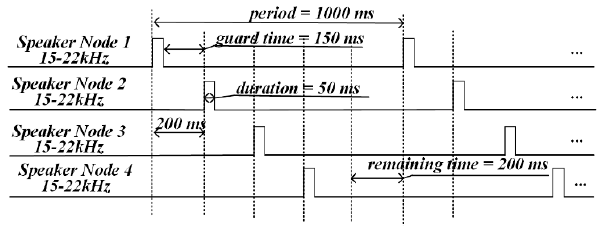
Figure 11. TDMA-only transmission scheme. Table 2. Specific parameter values of three TDMA-only transmission schemes.